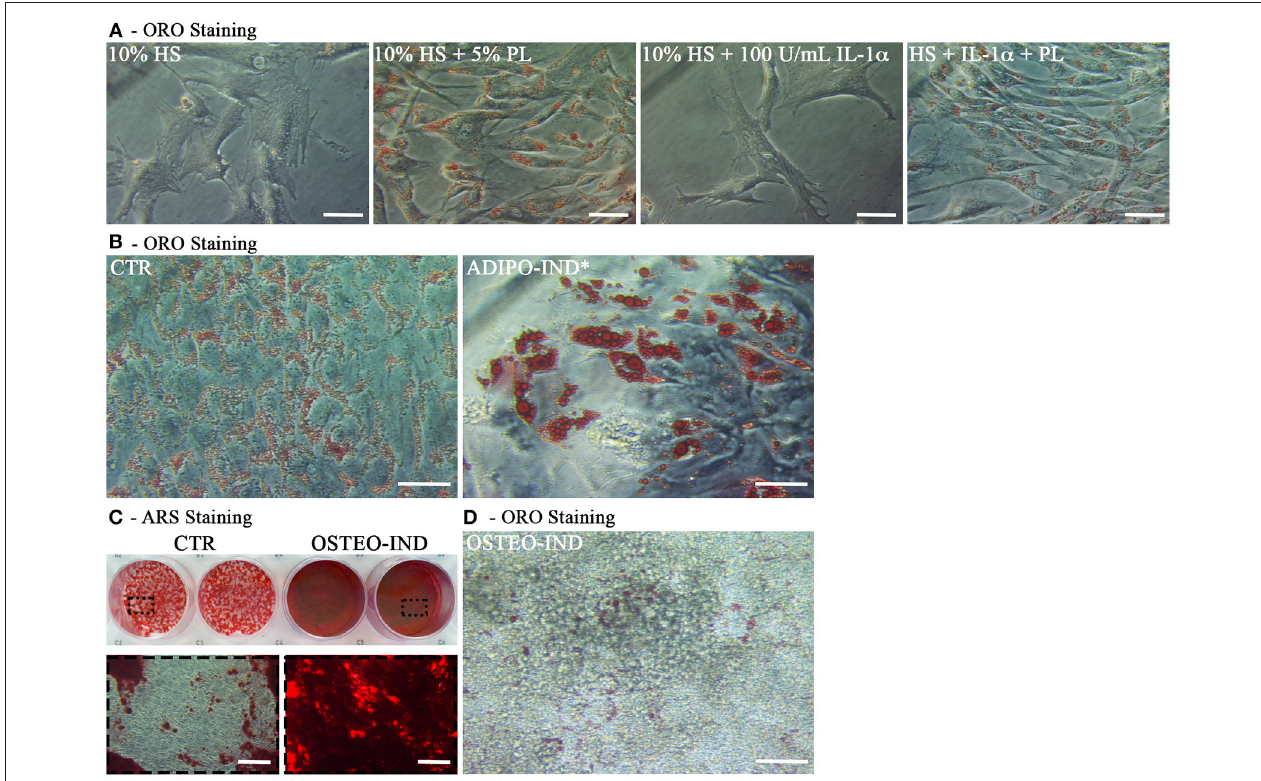
FIGURE 9 | Characterization of cells outgrown from in toto hAT samples cultured ex vivo using complete medium supplemented with 5% PL, 100 U/mL IL-1 α , or 5% PL + 100 U/mL IL-1 α , or without any supplement, for 14 days. (A) Representative ORO staining of outgrown cells at passage 0 in all different culture conditions (scale bars = 50 µ m); (B) Representative ORO staining of cells outgrown from the HS + PL-stimulated hAT, cultured for 3 passages in HS-supplemented medium, in the absence of PL, and induced or not induced toward adipogenesis (scale bars = 50 µ m); (C) Representative ARS staining of cells outgrown from the HS + PL-stimulated hAT, cultured for 3 passages in HS-supplemented medium, in absence of PL, and induced or not induced toward osteogenesis. Lower images are magnifications of highlighted areas (scale bars = 200 µ m); (D) Representative ORO staining of osteogenesis-induced cells (scale bars = 50 µ